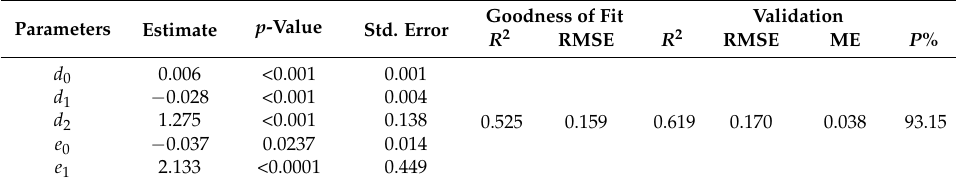
Table 4. Parameter estimates for the extinction coefficient ( k ) model of planted Larix olgensis trees and the goodness of fit and validation statistics. p -value: the level of significance for the parameter estimations, Std. error: standard error for the parameter estimations, Tree no.: tree number; R 2 : coefficient of determination, RMSE: root mean square error, ME: mean error, P %: precision estimation. Goodness of Parameters Estimate p -Value Std. Error